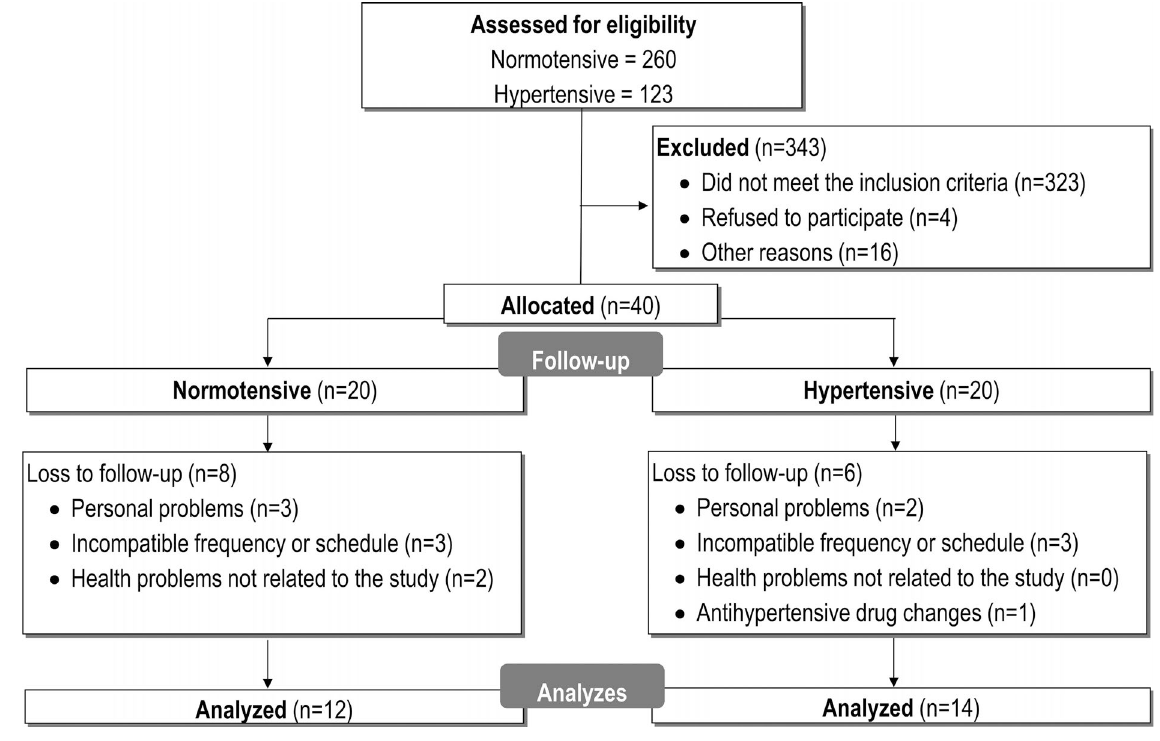
Figure 2 - Follow-up